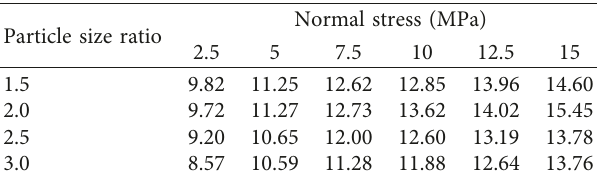
Table 7: Shear strength of specimens with different particle size ratios under normal stress. Particle size ratio